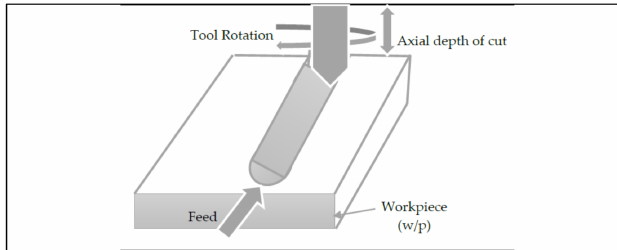
Figure 4. Schematic diagram illustrating the milling process. Table 4. Experimental